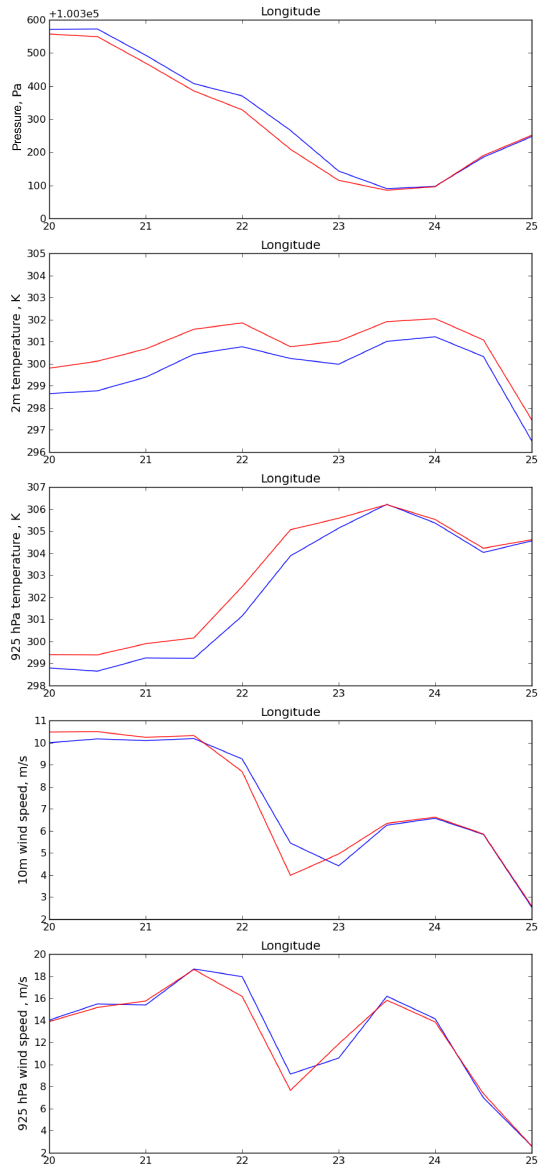
Figure 13. Same as Fig. 10 for REF (blue) and LW (red), cross section at 22 ◦ N, 24h